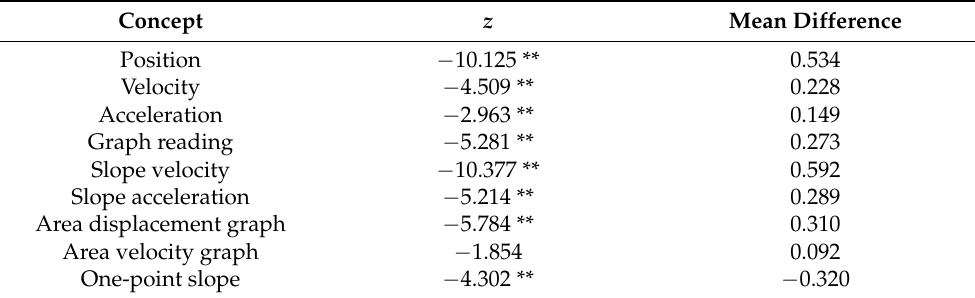
Table 6. The values of the Mann–Whitney U-test for comparing differences in the perceived mental effort of Serbian and North Macedonian students for observed concepts.